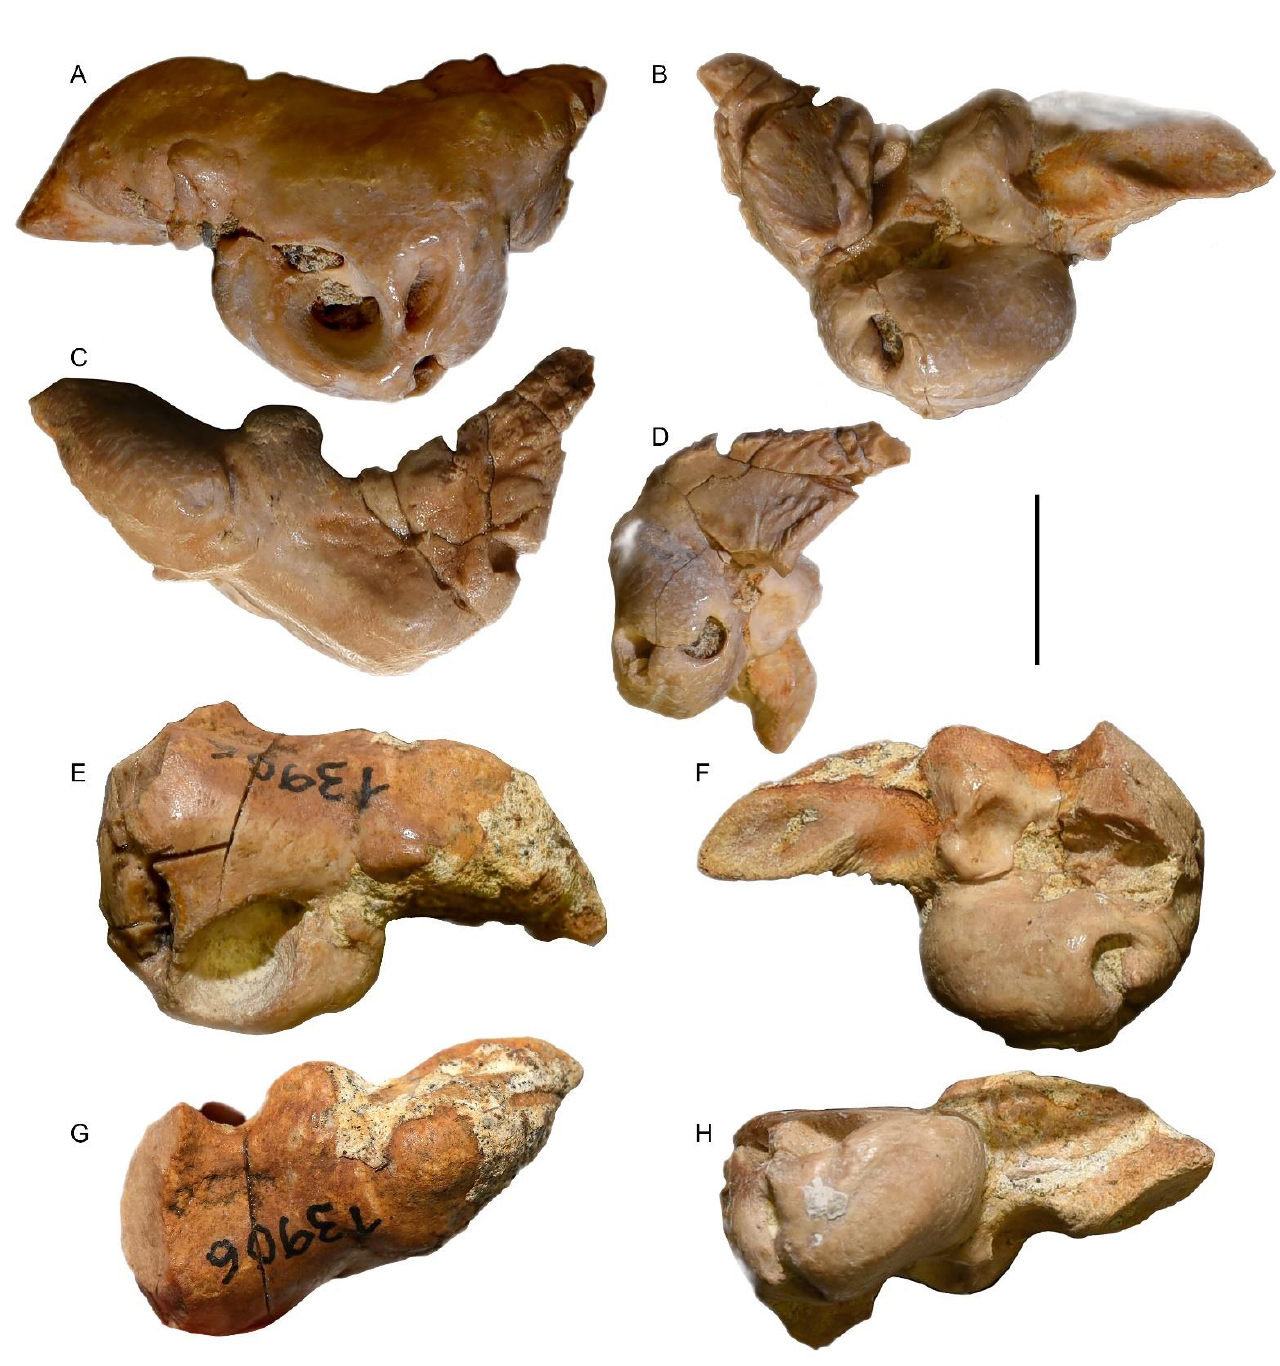
Figure 11. Periotics. ( A – D ) MGPT-PU 13881/2. ( A ) Medial view. ( B ) Lateroventral view. ( C ) Dorsal view. ( D ) Posterior view. ( E – H ) MGPT-PU 13906. ( E ) Medial view. ( F ) Lateral view. ( G ) Dorsal view. ( H ) Ventral view. Scale bar equals 2 cm.